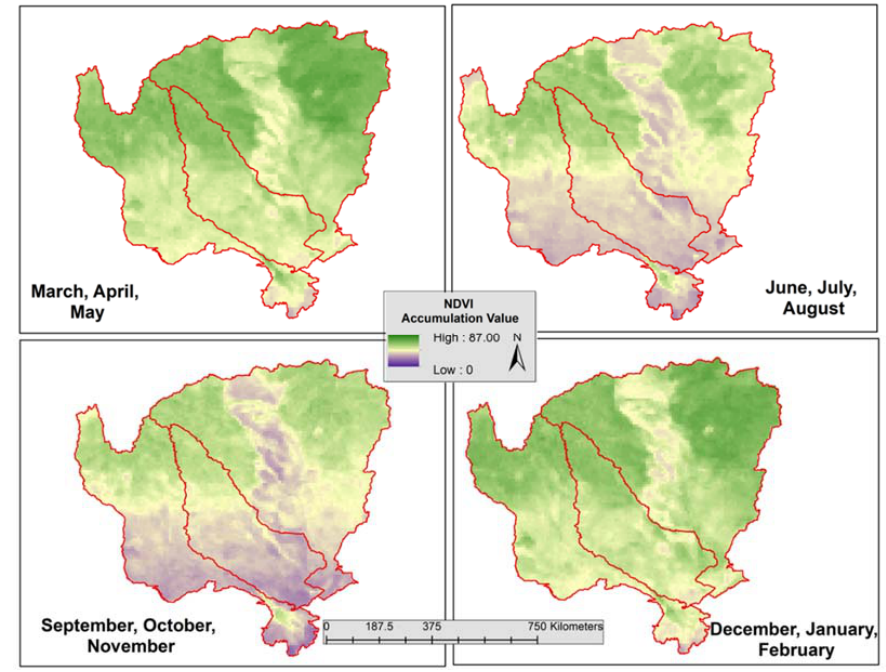
Figure 5. Total NDVI accumulation across by season for 1982–2010. for ( A ) March, April, May [MAM]; ( B ) June, July, August [JJA]; ( C ) September, October, November [SON]; and ( D ) December, January, February [DJF]. The red boundary highlights the drainage basins across the region.